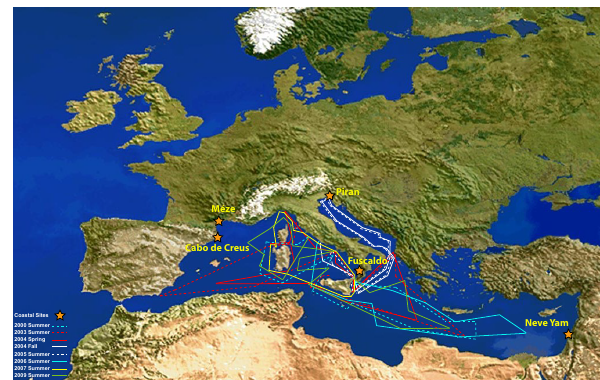
Fig. 1. The routes taken by the R. V. Urania during the Med- Oceanor oceanographic campaigns. The Adriatic campaign of au- tumn 2004 and summer 2005 are in